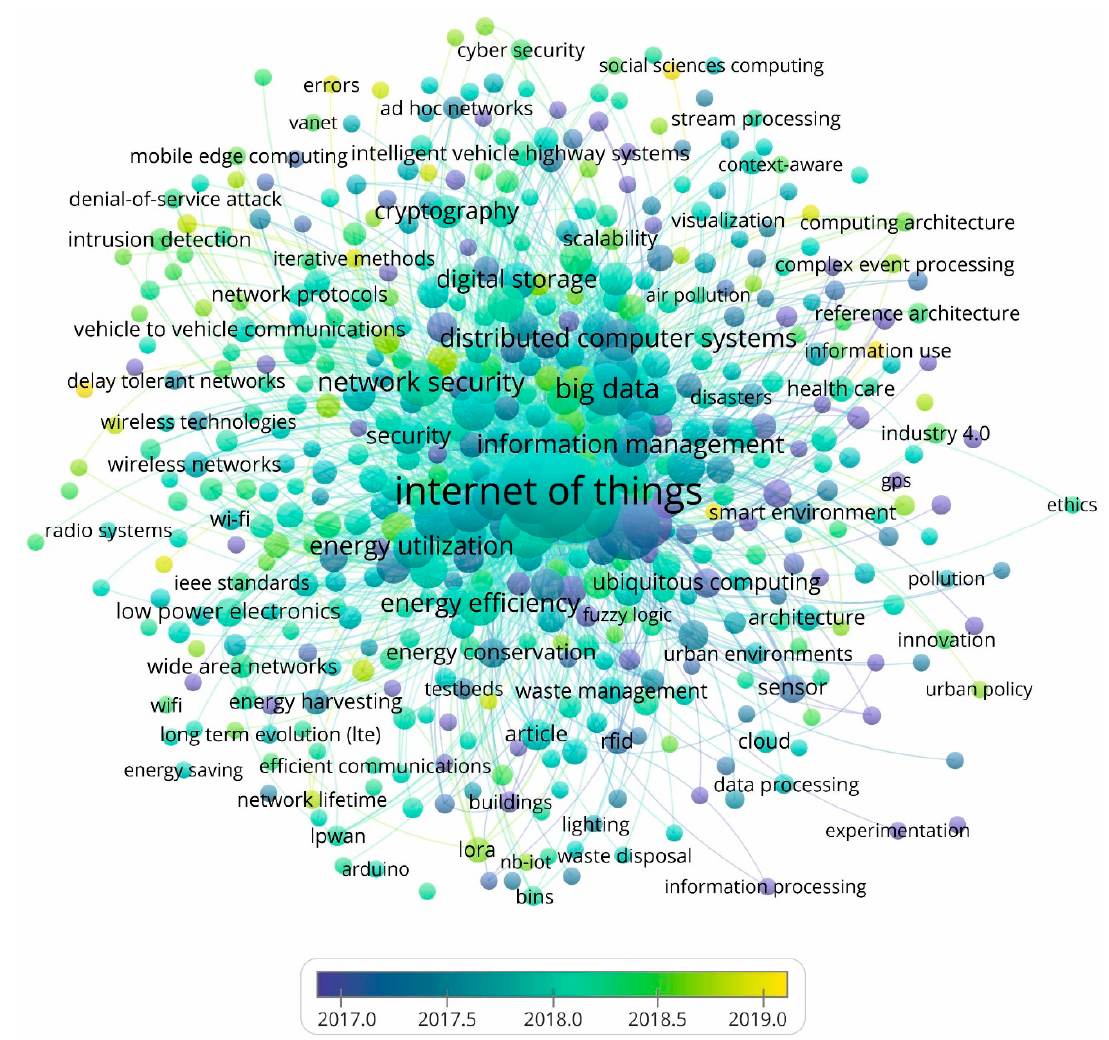
Figure 9. Evolution of keywords network based on co-occurrences (2011–2019).